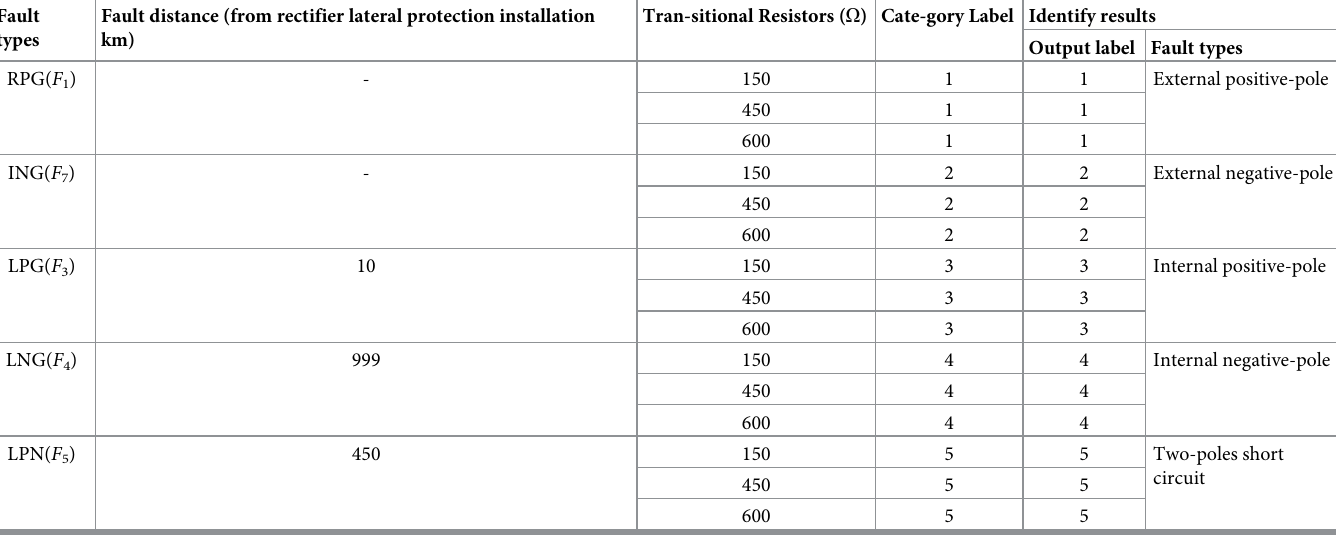
Table 5. Simulation verification results when faults with different transitional resistances